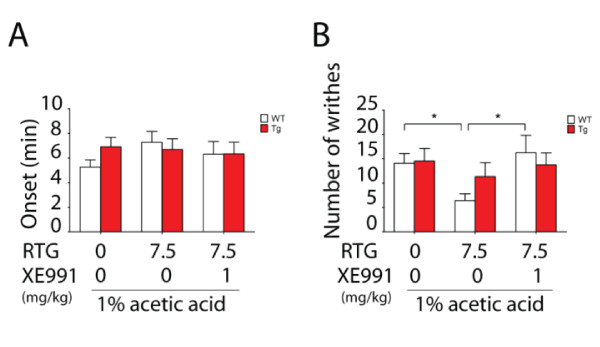
Antinociceptive effects of KCNQ channel opener retigabine on visceral pain induced by acetic acid in wild type mice, but not transgenic mice. The onset time (A) and the total number of writhes (B) were determined with vehicle or retigabine (RTG, 7.5 mg/kg) or RTG (7.5 mg/kg) co-injected with XE991 (1 mg/kg) administration (i.p.) before 1% acetic acid (i.p.) injection in both wild type (WT) and transgenic (Tg) groups. Data are expressed as mean ± s.e.m (n = 8-13). RTG (7.5 mg/kg, i.p.) significantly reduced the number of writhes in WT mice, and co-injection of RTG (7.5 mg/kg, i.p.) with XE991 (1 mg/kg, i.p.) reversed the antinociceptive effect of RTG (*p < 0.05).